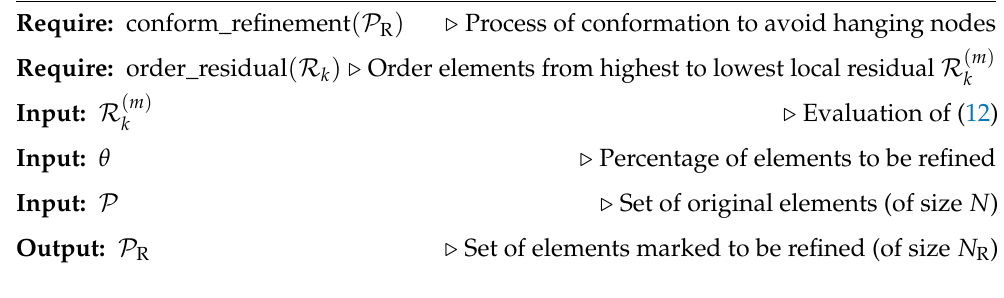
Algorithm 2 Quantile marking strategy based on [39]